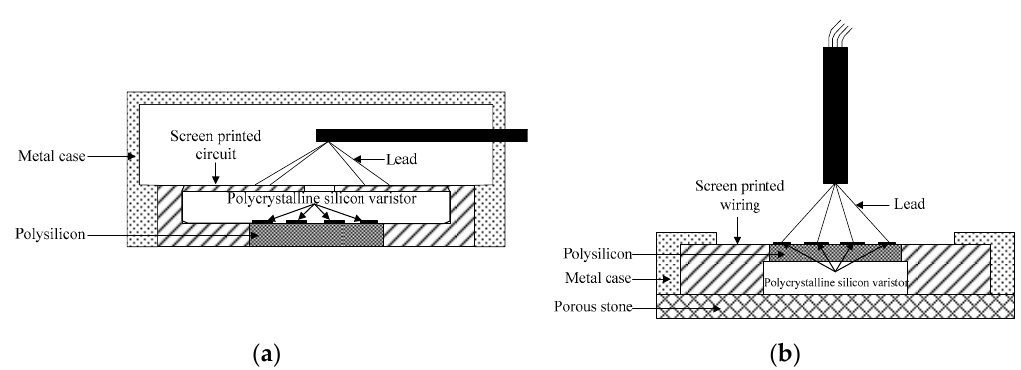
Figure 3. Schematic diagram of miniature silicon piezoresistive pressure sensor package: ( a ) Lateral outgoing earth pressure sensor and ( b ) bottom outgoing pore water pressure sensor.